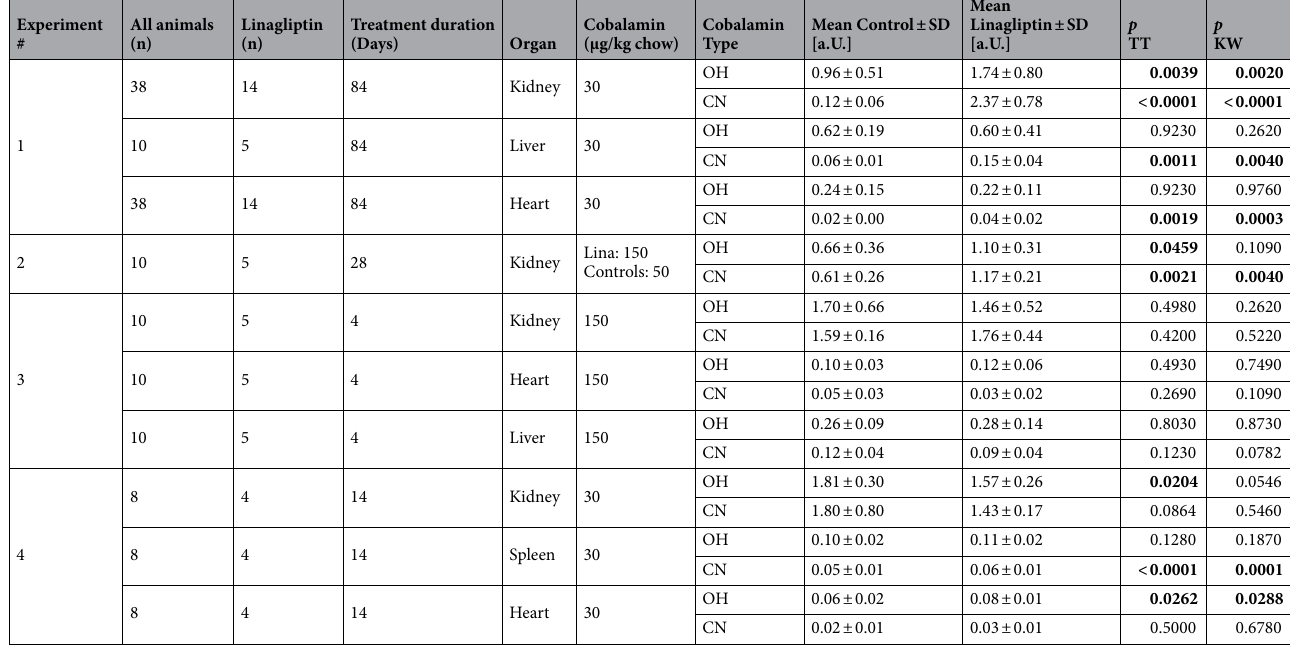
Table 1. Experimental parameters and mean values of Cbl forms in different organs. a.U. arbitary unit; CN cyano; KW Kruskal–Wallis; Lina linagliptin; OH hydroxy; SD standard deviation; TT Welch t-test.